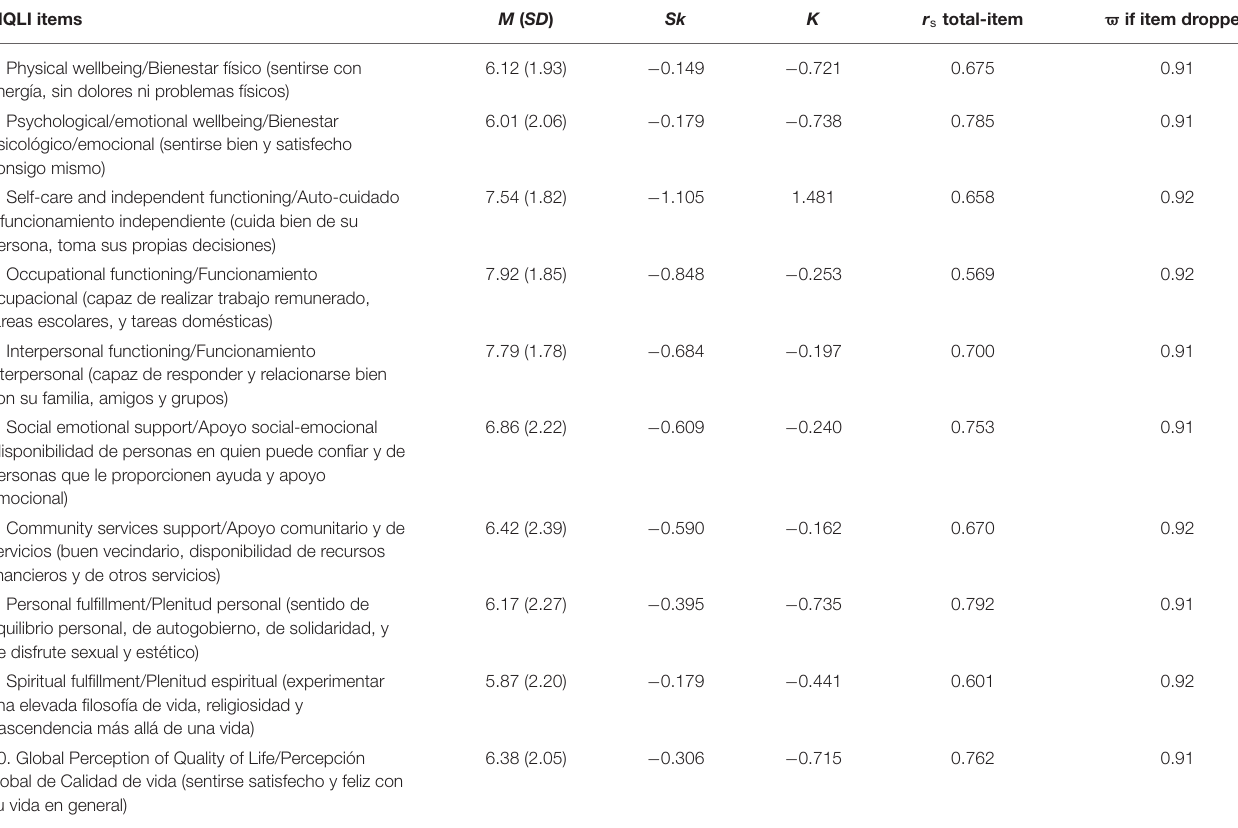
TABLE 3 | Descriptive statistics, correlations of the MQLI, and ̟ if item is dropped from the MQLI (men’s subsample). MQLI items M ( SD ) Sk K r s